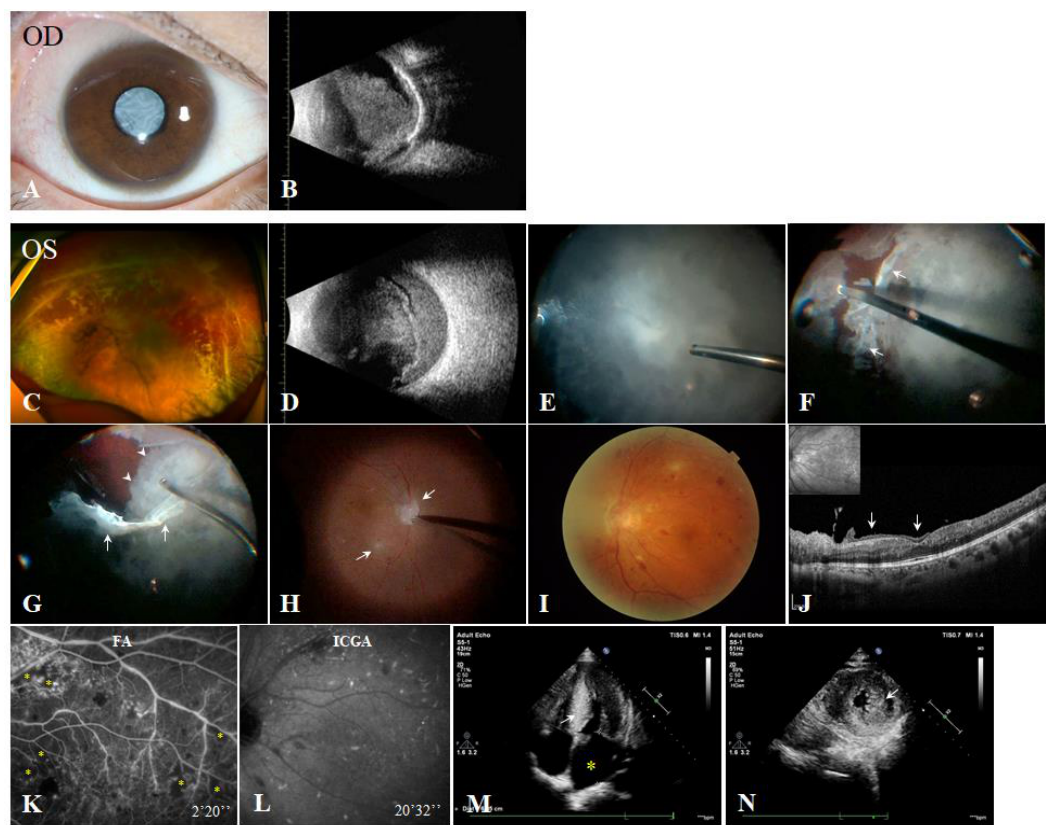
Figure 3. Case 2. ( A ) Anterior segment photograph of the right eye. ( B ) B-scan ultrasound image of the right eye, showing vitreous opacities and calcification of the eyeball wall. ( C ) Preoperative fundus photograph of the left eye, showing vitreous haze. ( D ) B-scan ultrasound image of the left eye, showing opacities in the vitreous cavity and preretinal space. ( E – H ) Intraoperative snapshot images showed cotton wool-like opacities ( E ), dense posterior hyaloids ( F , G , white arrows), velvet deposits in the preretinal space ( G , white arrowheads) and white deposits adhered to the optic disc and retina ( H , white arrows). ( I ) Postoperative fundus photograph of the left eye, showing multiple hemorrhagic spots. ( J ) Postoperative optical coherence tomography image, showing deposits adhering to the surface of the retina and blurred retinal structures. ( K ) Fluorescein angiography of the left eye showed multiple areas of telangiectasis and nonperfusion. ( L ) Indocyanine green angiography of the left eye, showing hypercyanescence along the choroid vessels. ( M ) Apical four-chamber view of the heart on echocardiography, indicating left atrial enlargement and thickening of the ventricular septum. ( N ) Parasternal short-axis view at the level of the mitral valve, indicating hypertrophy of the left ventricular